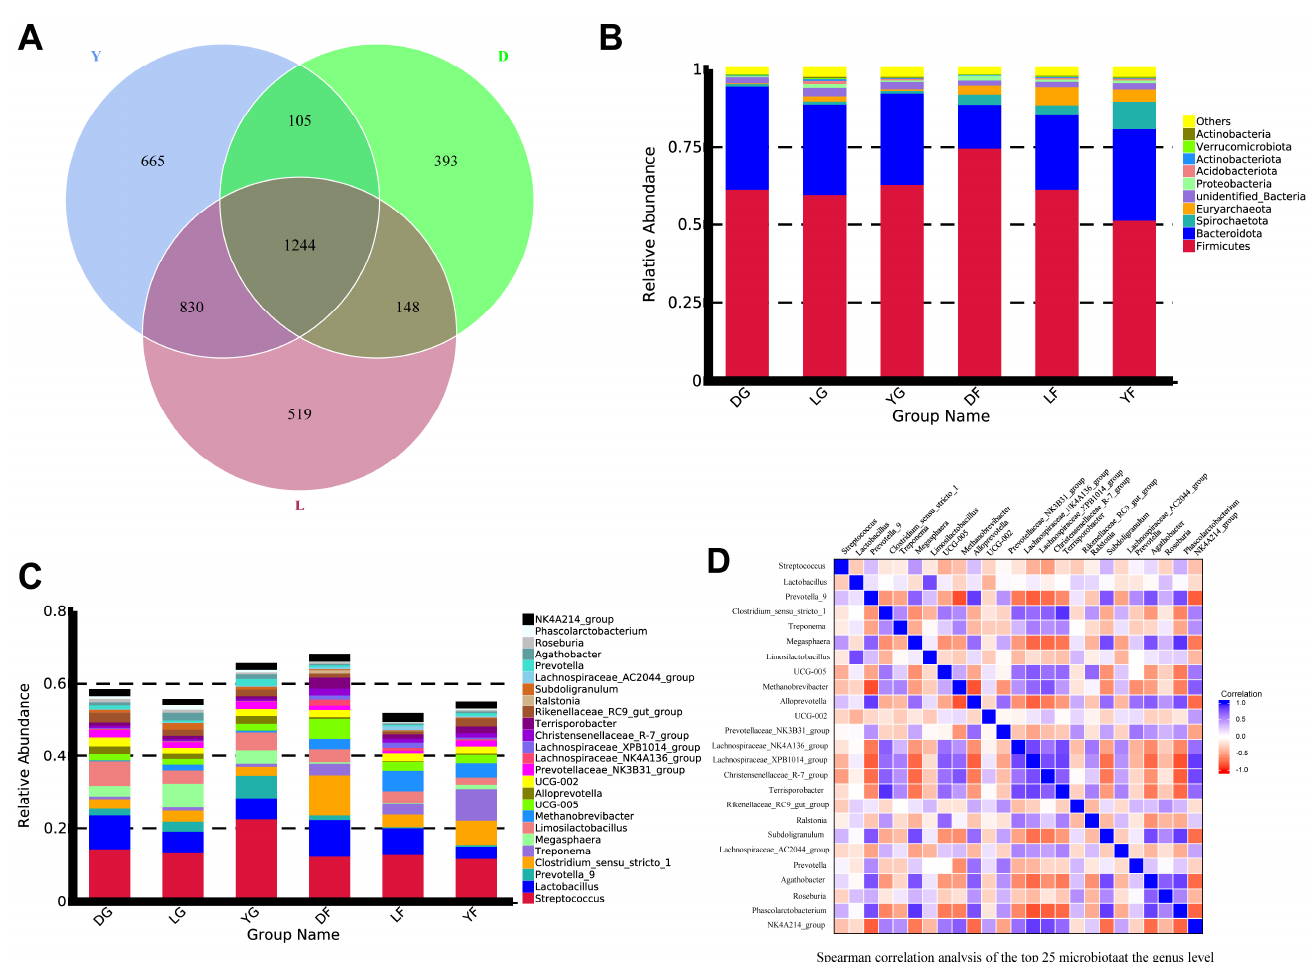
Figure 3. Number of operational taxonomic units (OTUs) and abundance analysis of annotated species in the gut microbiota of gilts of three different breeds at early and finishing growth stages. ( A ) Venn diagram of the number of OTUs in different pig breeds. D—Duroc; L—Landrace; Y—Yorkshire. ( B ) Histogram of the phylum-level relative abundance at the phylum level in different sample groups. DG—Duroc at early growth stage; LG—Landrace at early growth stage; YG—Yorkshire at early growth stage; DF—Duroc at finishing stage; LF—Landrace at finishing stage; YF—Yorkshire at finishing stage. ( C ) Histogram of the genus-level relative abundance in different sample groups. ( D ) Heatmap of Spearman correlation coefficients at the genus level.